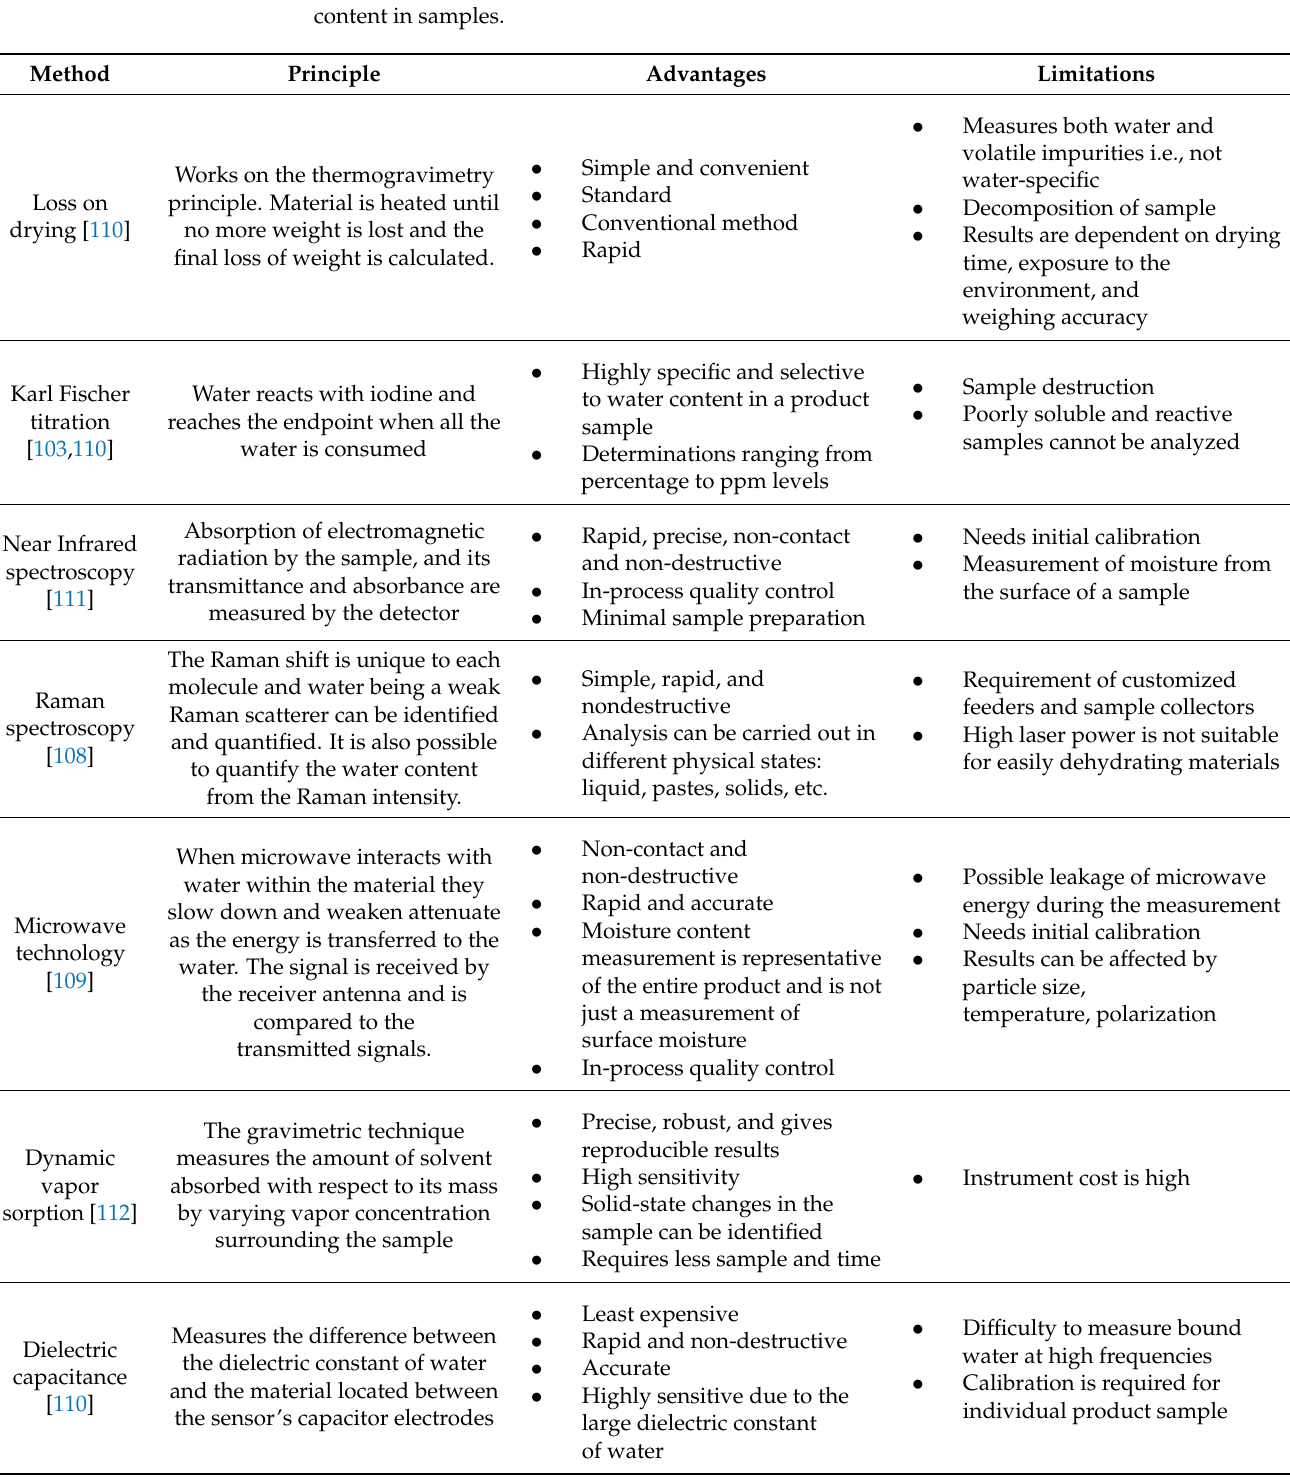
Table 6. Principle advantages and limitations of various methods for determining the moisture content in